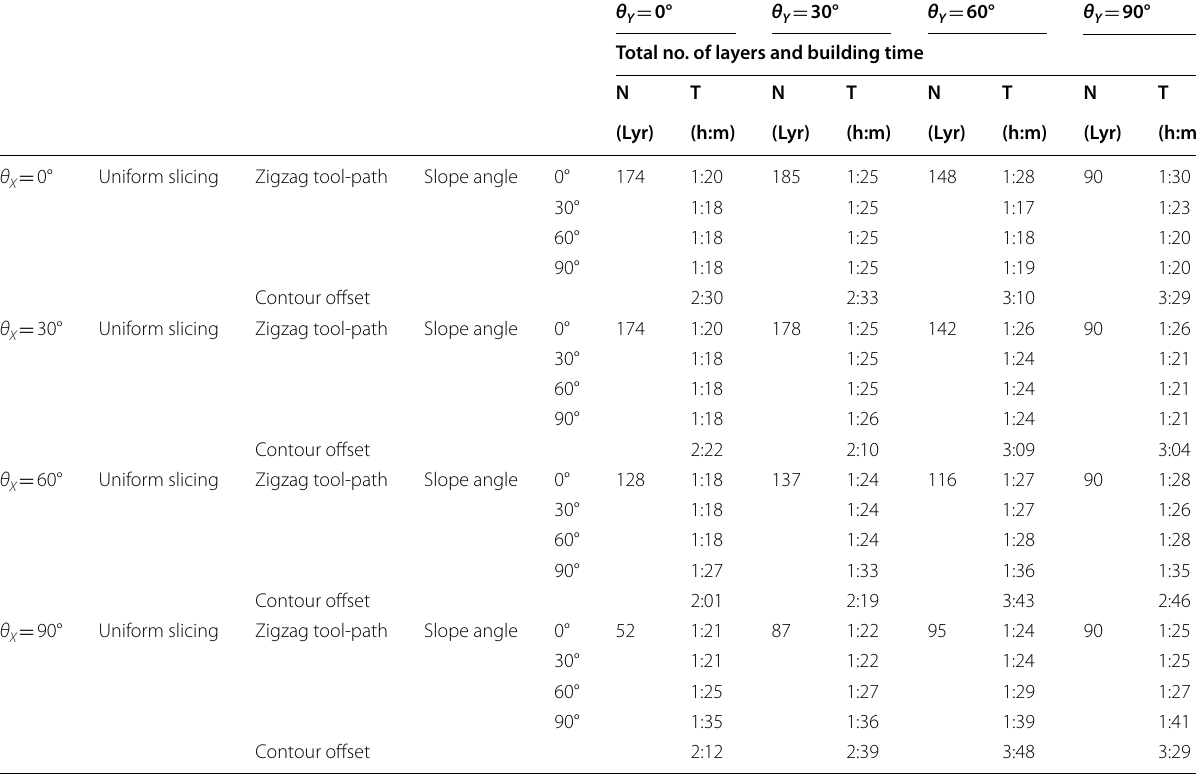
Table 2 Evaluation of building time criteria in the case study